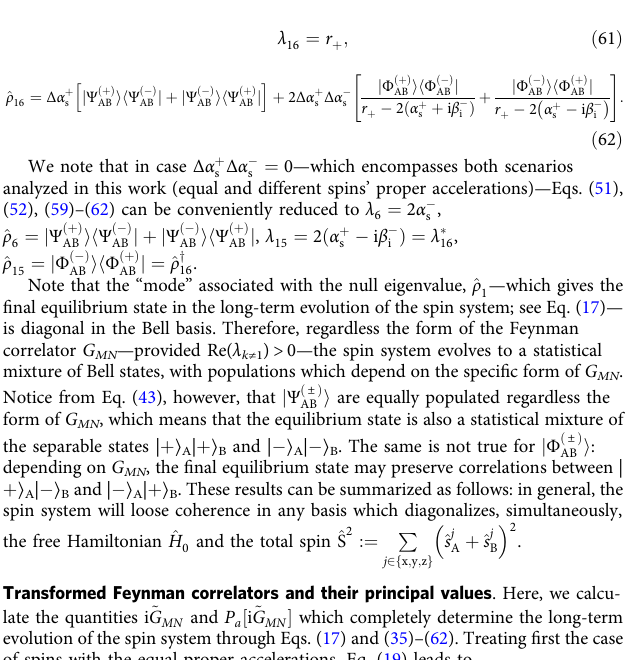
ffiffiffiffiffiffiffiffiffiffiffiffiffiffiffiffiffiffiffiffiffiffiffiffiffiffiffiffiffiffi p ð α (cid:2) s Þ 2 þ 4 α þ i ð α þ i þ α (cid:2) i Þ